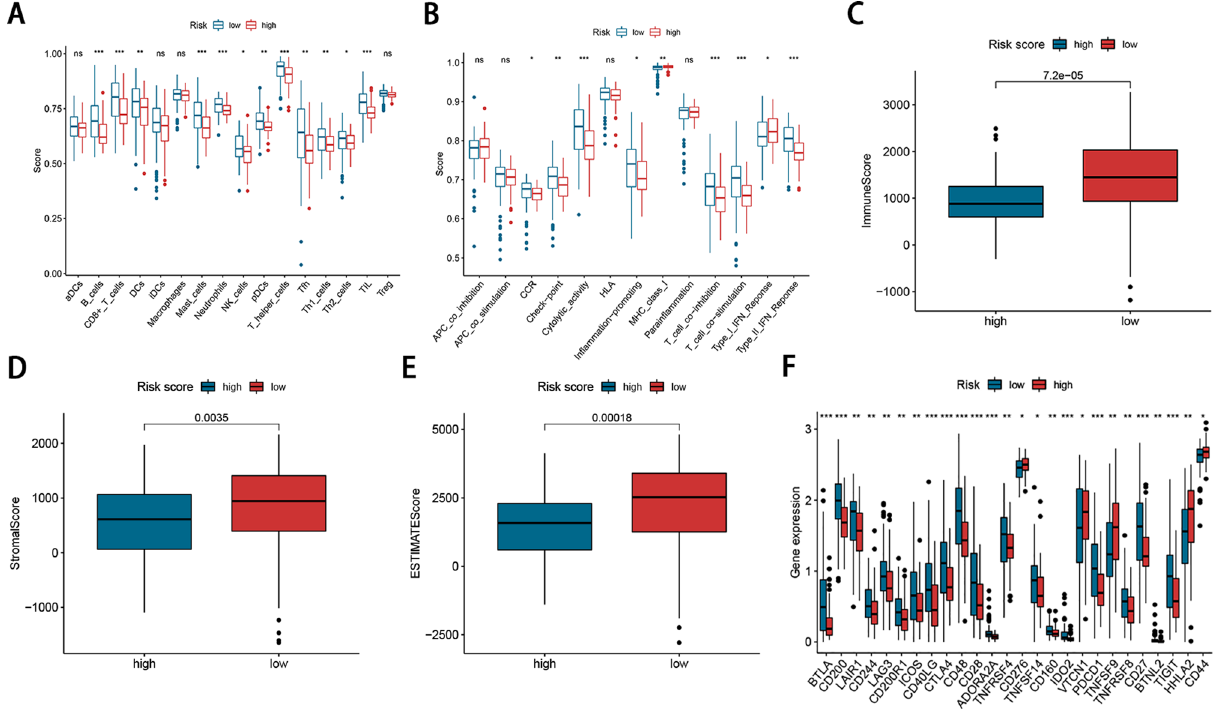
Figure 3. Immune infiltration analysis between the two risk groups. ( A , B ) Boxplot of immune cells and immune function between high and low risk groups. ( C – E ) Association the risk score and the TME score (immune scores, stromal scores, and ESTIMATE scores). ( F ) Expression of immune checkpoints in high and low risk